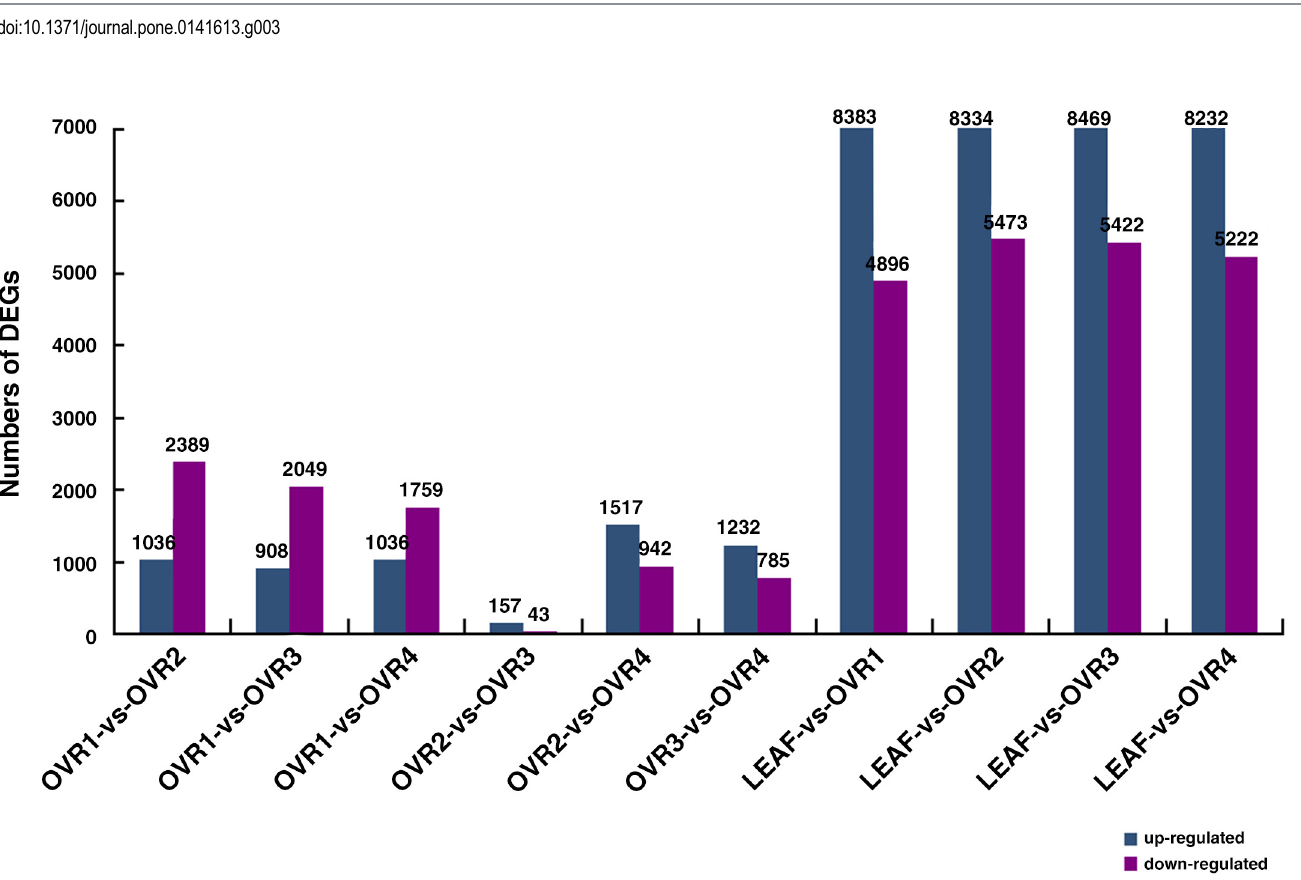
Fig 4. Different expressed genes identified between 10 comparisons (OVR1-vs-OVR2, OVR1-vs-OVR3, OVR1-vs-OVR4, OVR2-vs-OVR3, OVR2-vs- OVR4, OVR3-vs-OVR4, LEAF-vs-OVR1, LEAF-vs-OVR2, LEAF-vs-OVR3, LEAF-vs-OVR4). The numbers of up-regulated and down-regulated genes were revealed.